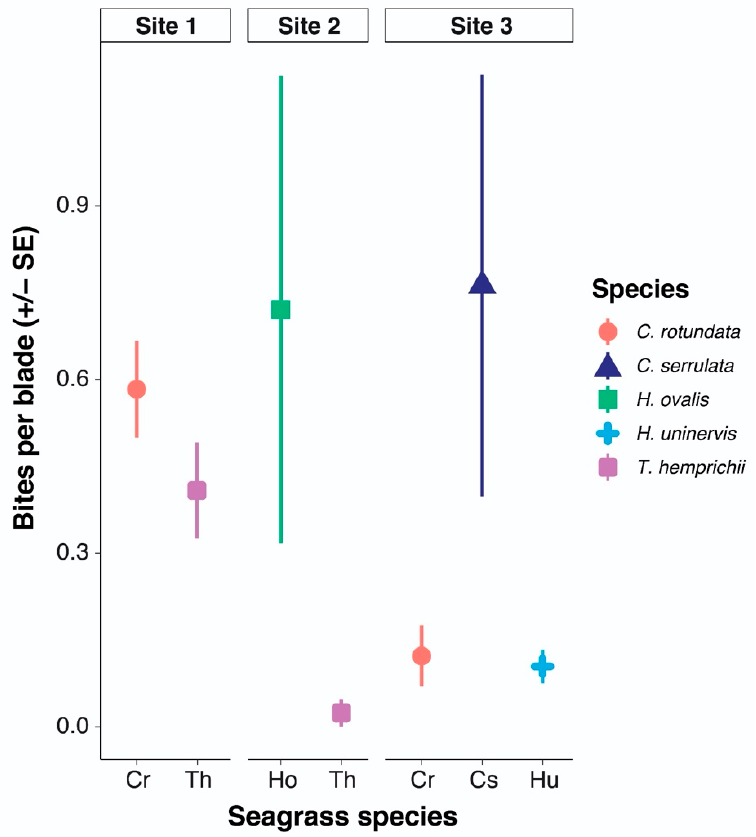
Figure 4. Bites per seagrass blade in control plots of all species found at all sites.